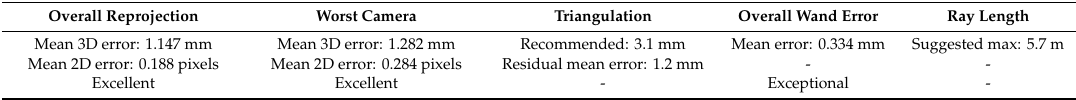
Table 2. Optical motion capture calibration